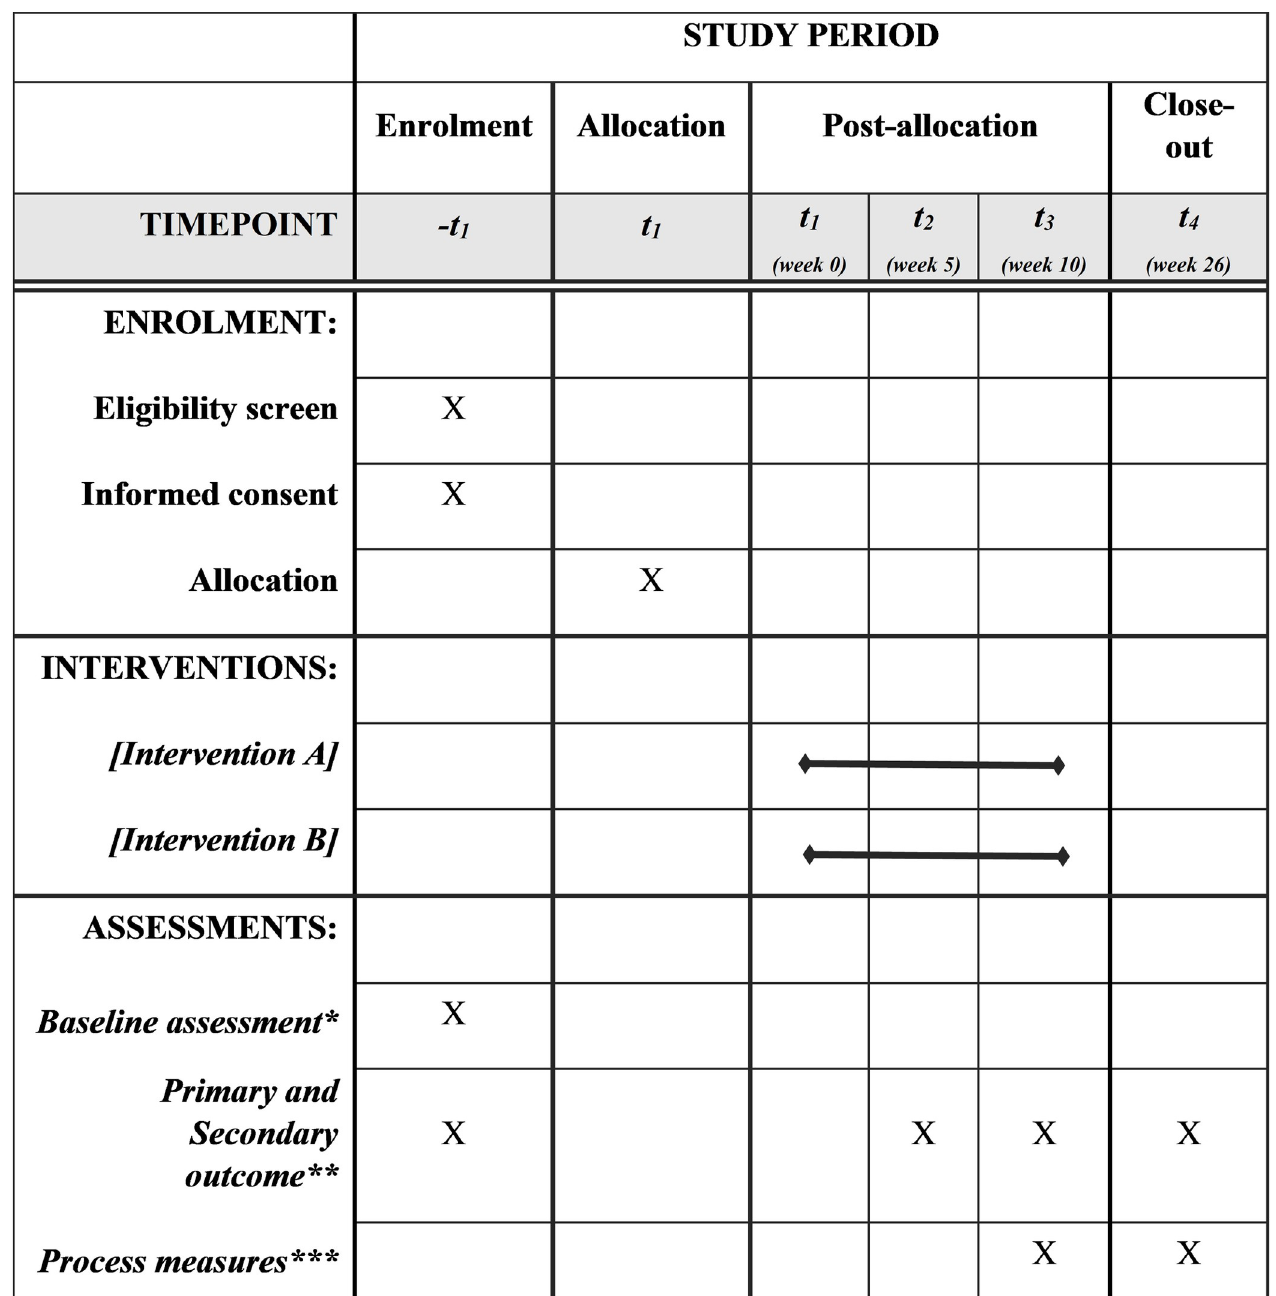
Fig 1. Schedule of enrolment, interventions, and assessments. � Sociodemographic, clinical, and lifestyle characteristics. �� Primary outcome: Pain intensity and functional limitation. Secondary outcome: Neuropathic-like symptoms, sciatic neurodynamic, conditioned pain modulation, and psychosocial factors. ��� Adherence assessment, serious adverse events and adverse events, and assessment of patient